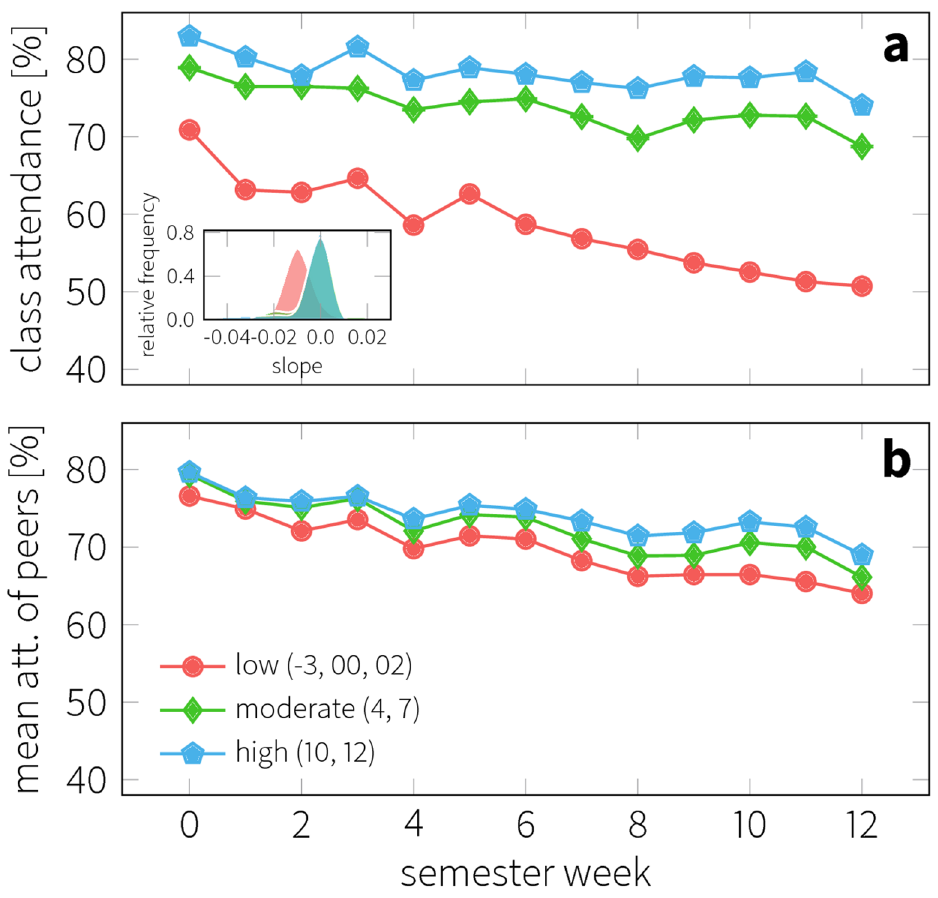
Fig 5. Change in class attendance over a single semester. a) Trends of attendance observed in the three performer groups: low (red circles), moderate(green diamonds) and high performers (blue pentagons), accordingto the Danishgradingsystem. Inset shows the distribution of slopes measuredfor each pairs of data point in the trends. b) Mean attendance measuredamong the contacts of the students basedon exchangedtext